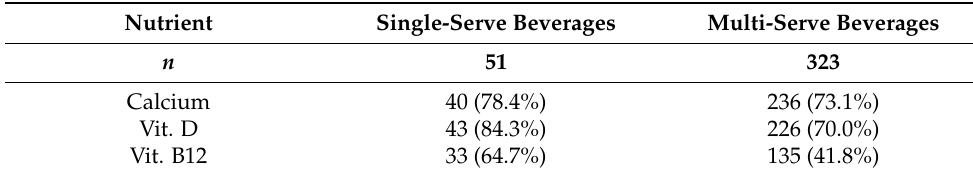
Table 2. Number (%) of non-dairy beverages that are fortified with calcium, vitamin D, and vita- min B12. Nutrient Single-Serve Beverages